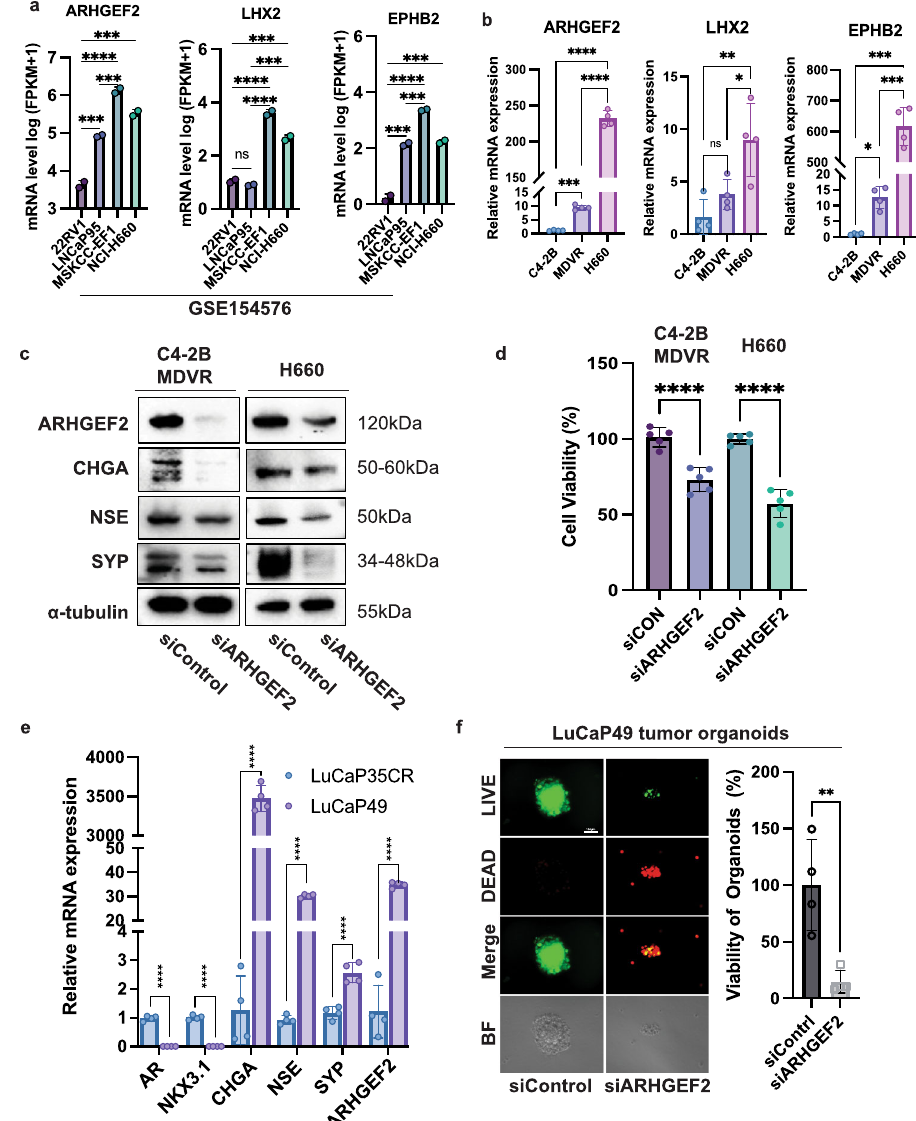
Fig. 6 Downregulating neural lineage marker ARHGEF2 gene expression decreased C4-2B MDVR and H660 cell viability. a FPKM value of ARHGEF2 , LHX2 and EPHB2 gene expression in 22RV1, LNCaP95, MSKCC-EF1 and H660 cells from GSE154576 dataset ( n = 2). b Relative mRNA level of ARHGEF2 , LHX2 , and EPHB2 in C4-2B parental, MDVR, and H660 cells ( n = 4). c Knocking down ARHGEF2 by siRNA decreased the expression of the markers of neuroendocrine including CHGA, NSE, and SYP in C4-2B MDVR and H660 cells. C4-2B MDVR and H660 cells were transfected with siRNAs for ARHGEF2 for 48 h, total cell lysates were collected and subjected to western blot analysis. d Knocking down ARHGEF2 by siRNA inhibited cell viability of C4-2B MDVR and H660 cells. C4-2B MDVR and H660 cells were transiently transfected with siRNAs targeting ARHGEF2 and viable cells were quanti fi ed using CellTiter Glo assay ( n = 5). e qPCR analysis of AR targets and neuroendocrine markers and ARHGEF2 in NEPC LuCaP49 patient-derived xenograft (PDX) tumors and prostate adenocarcinoma LuCaP35CR tumors ( n = 3). f Downregulation of ARHGEF2 by siRNA inhibits the growth of organoids derived from LuCaP49 PDX tumors. LuCaP49 organoids were seeded in a 96-well plate in the format of 3D Matrigel and then transfected with 50 nM ARHGEF2 siRNA and cultured for 14 days. The viability of the organoids was analyzed by CellTiter Glo and visualized by LIVE/DEAD staining ( n = 4). Green = Calcein staining of live cells, Red = Ethidium homodimer-1 staining of dead cells. Scale bar 100 µ m. * p < 0.05, ** p < 0.01, *** p < 0.001 (mean and SD in a , b , d , e , f ) using one-way ANOVA with multiple-comparisons